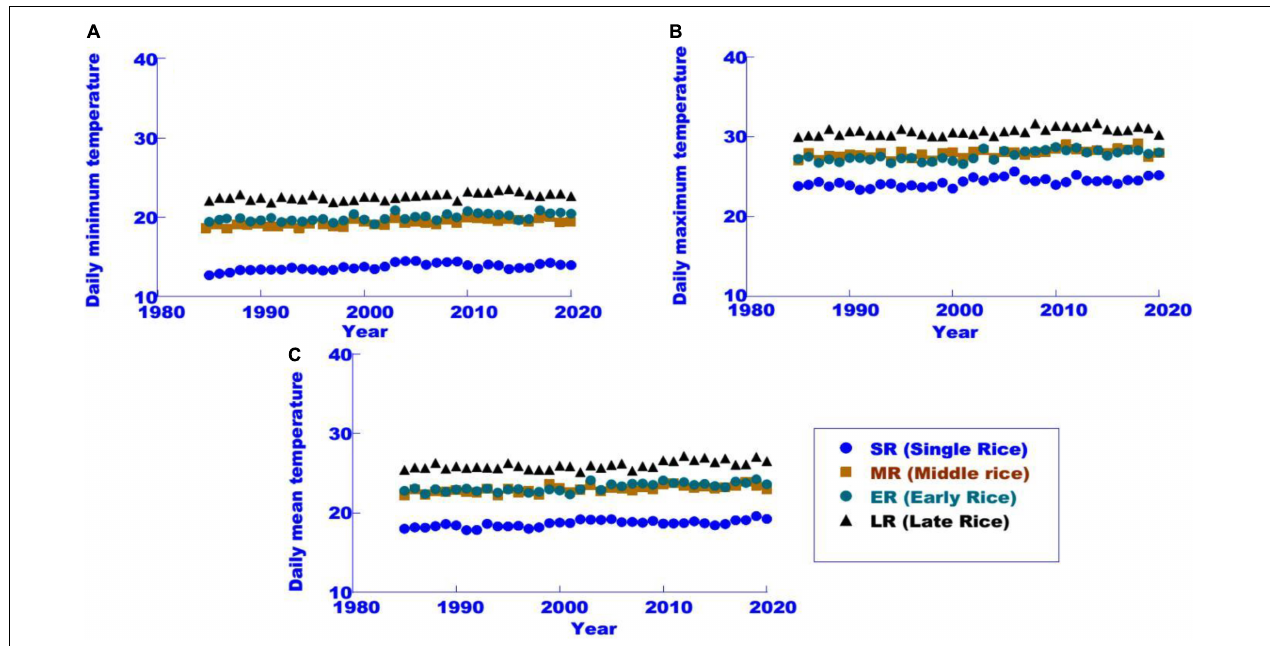
FIGURE 1 | Daily minimum temperature (A) , maximum temperature (B) , and average temperature (C) of the rice growing season in the main rice-growing regions of China during 1980–2020 (modified from Deng et al.,